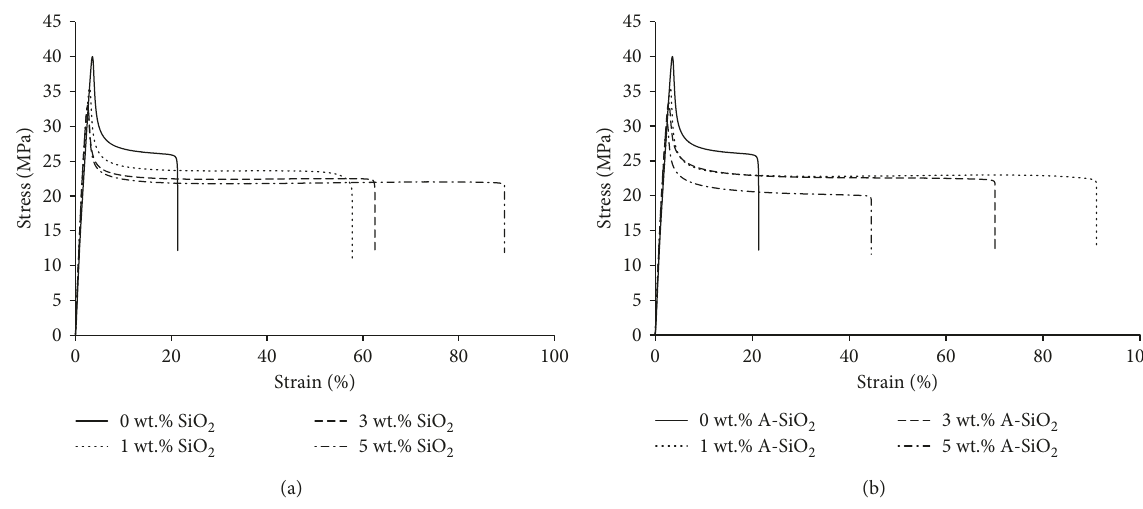
Figure 7: Stress-strain curves of PLA/MPLA/TPS/P composites with (a) SiO